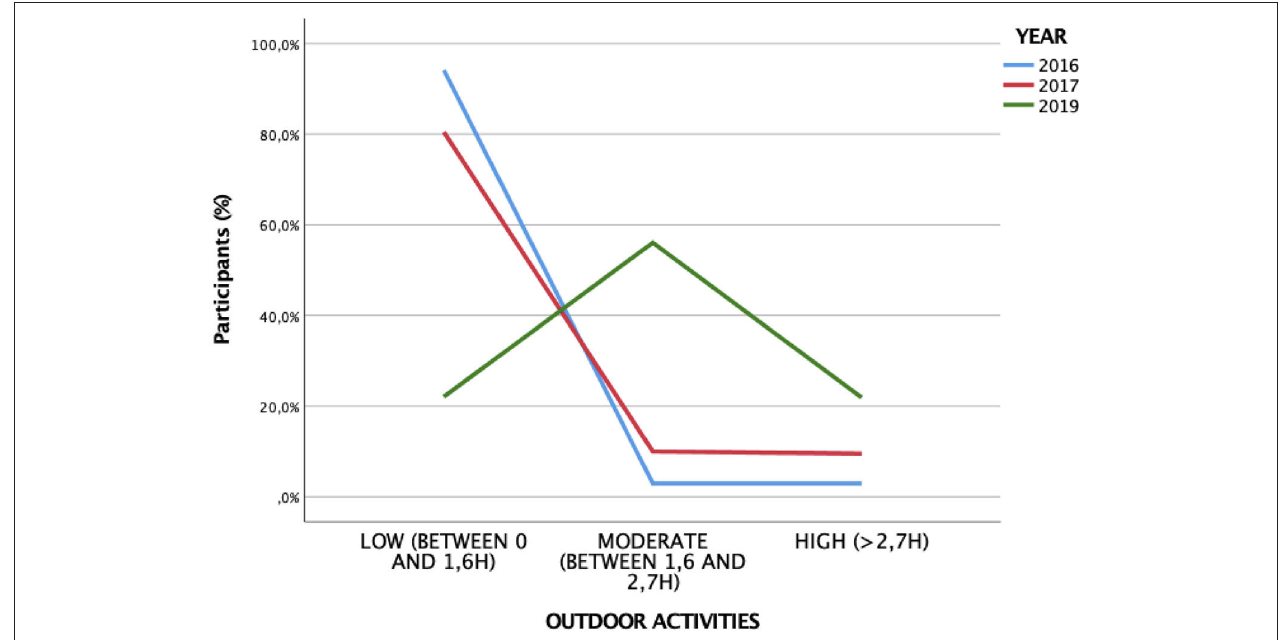
FIGURE 4 | Outdoors activities by